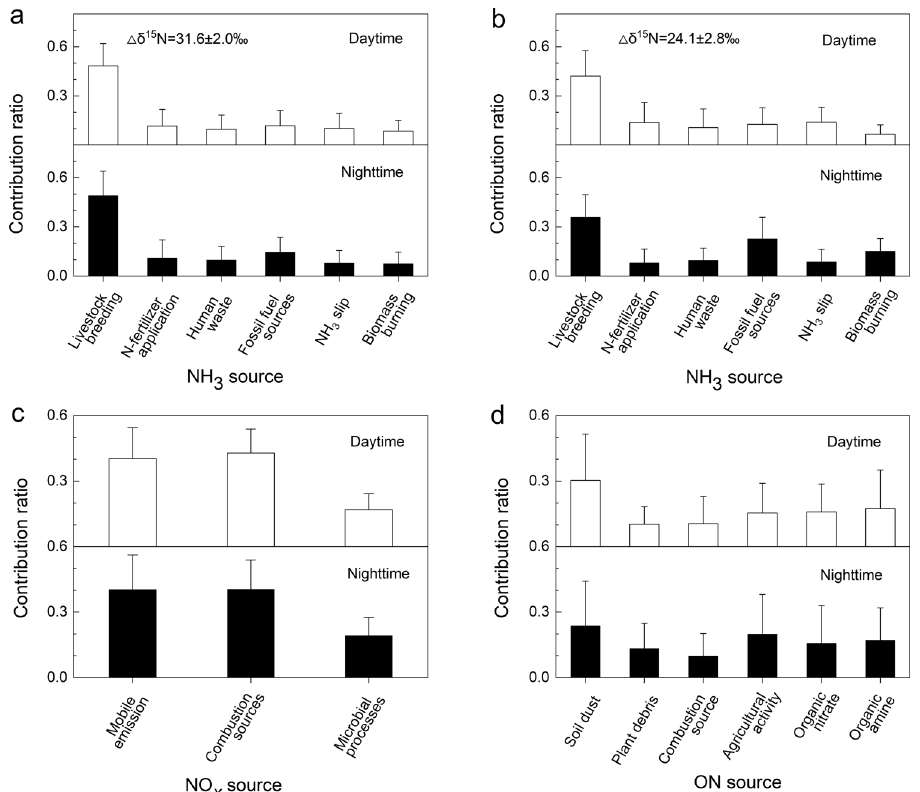
Fig. 3 Source apportionment results (average + standard deviation) of aerosol inorganic nitrogen and organic nitrogen (ON) in daytime and nighttime total suspended particles (TSP) over Mt. Tai in spring 2017, based on the MixSIAR model. Contributions of major NH 3 sources to NH 4 + in cases where a Δδ 15 N = 31.6 ± 2.0 ‰ and b Δδ 15 N = 24.1 ± 2.8 ‰ , respectively; c contributions of major NO x sources to NO 3 − ; d contributions of major sources to